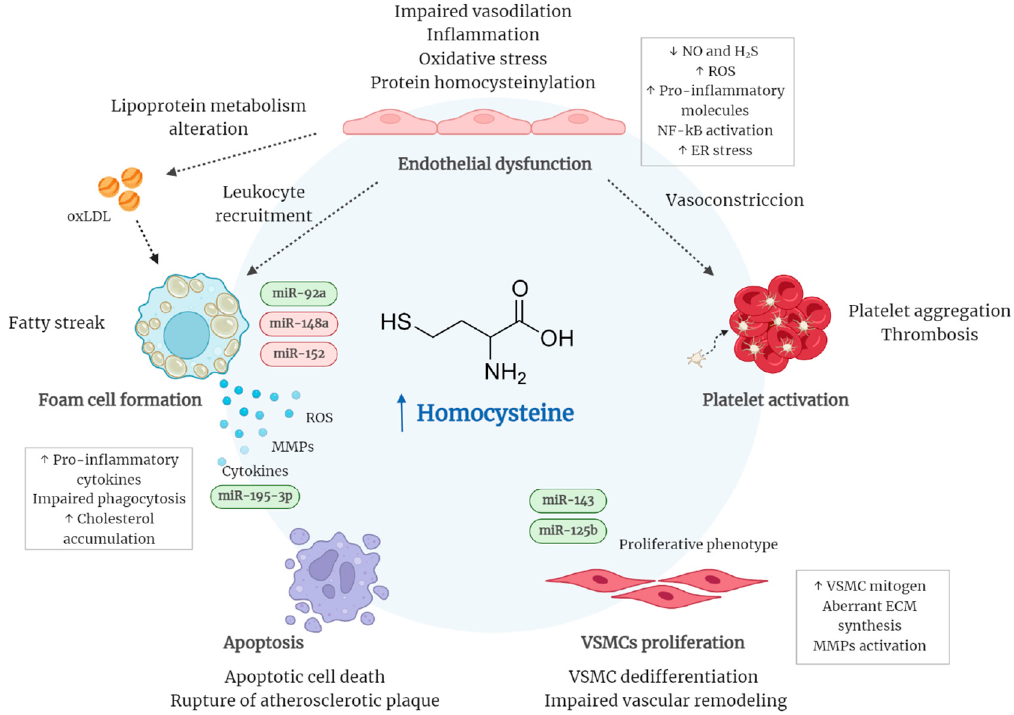
Figure 2. Schematic overview of the underlying mechanisms that mediate the adverse effects of HHcy in CVD. Elevated Hcy levels induce impaired vasodilation, inflammation, and oxidative stress leading to endothelial dysfunction. Oxidative stress can further stimulate platelet activation and apoptosis as well as alter lipoprotein metabolism, resulting in macrophage foam cell formation. Additionally, HHcy promotes the dedifferentiation of VSMCs into a proliferative phenotype, contributing to vascular remodeling. MicroRNAs that could be involved in some of the mechanisms have been also included. In green are those miRNAs that are downregulated and in red upregulated. Abbreviations: ECM, extracellular matrix; ER, endoplasmic reticulum; MMPs, matrix metalloproteinases; NF- κ B, Nuclear factor- κ B; NO, nitric oxide; oxLDL, oxidized low-density lipoprotein; ROS, reactive oxygen species; VSMCs, vascular smooth muscle cells.